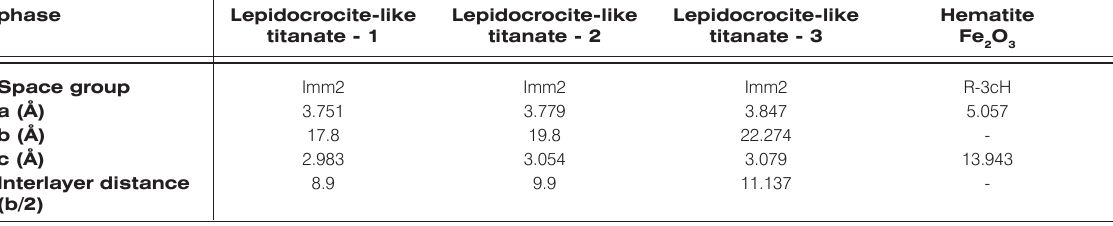
Figure 2. (a) SEM and (b) EDS of ilmenite sand. Table 2. LeBail refinement